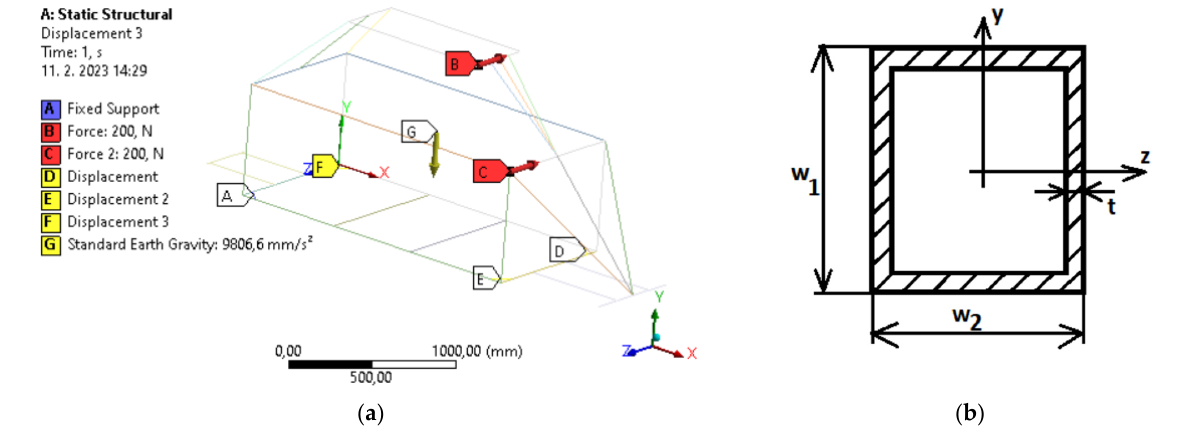
Figure 2. ( a ) Marginal conditions and FEM model load; ( b ) dimension optimization of the sections used.